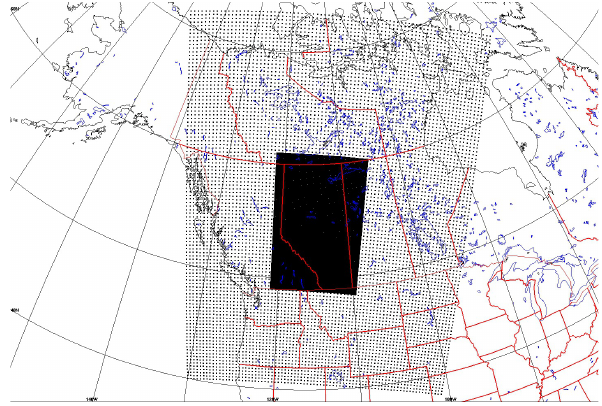
Fig. 10. 36- and 12-km domains, summer 2002 simulations over western Canada.